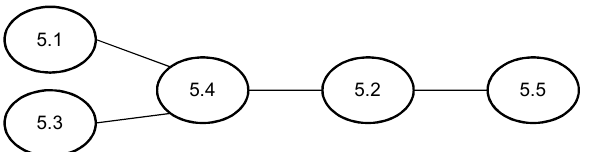
Fig. 6. Precedence diagram of Colombian Aid Management